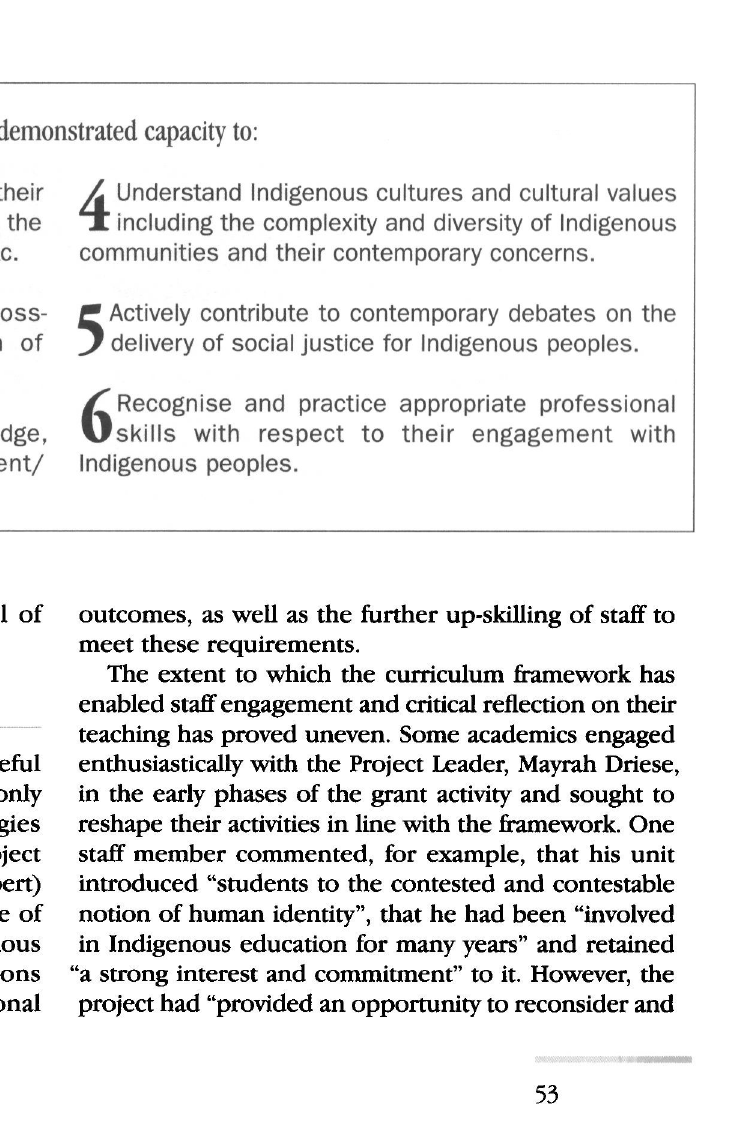
Figure 1. The guiding principles.